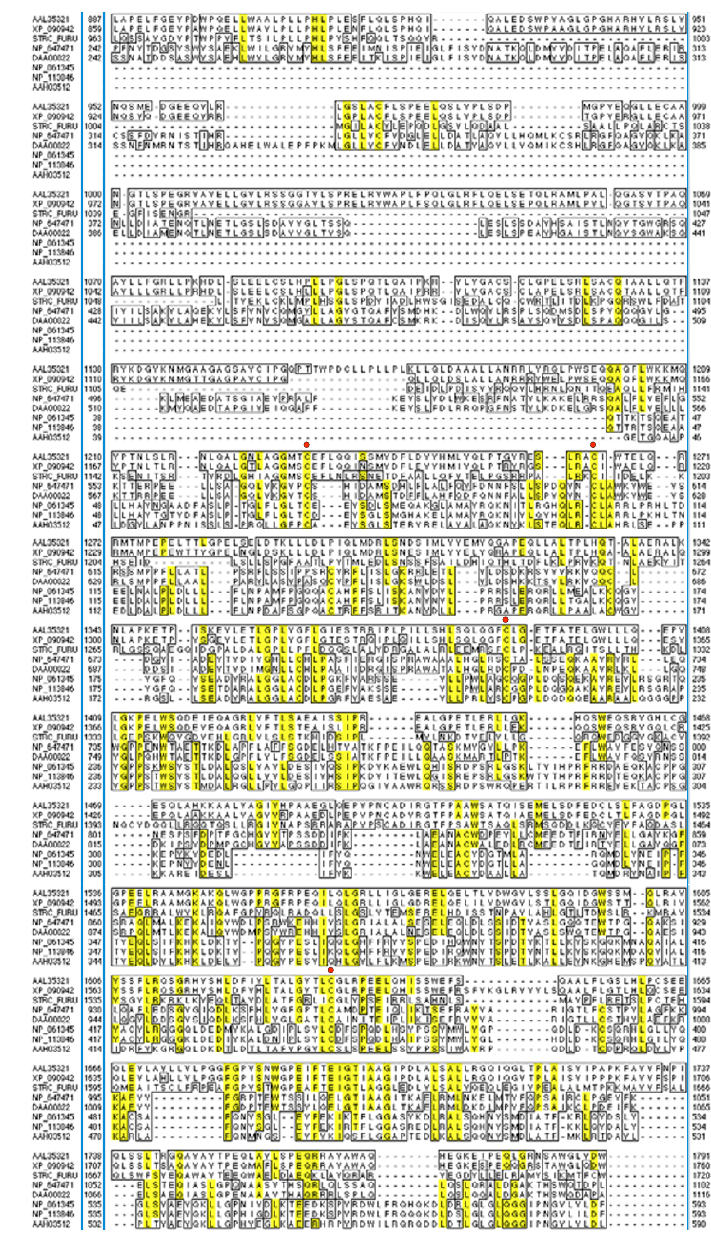
Figure 1 Multiple sequence alignment of stereocilin, otoancorin and mesothelin. Regions of homology are boxed, residues identical in more than 60% of the sequences are shaded in yellow and 4 cysteine residues conserved in all sequences are indicated by red dots. AAL35321, mouse stereocilin (1809 aa); XP_090942, human stereocilin (1778 aa); STRC_FURU, Fugu rubripes stereocilin (see below); NP_647471, mouse otoancorin (1137 aa); DAA00022, human otoancorin (1153 aa); NP_061345, mouse mes- othelin (625 aa); NP_113846, rat mesothelin (625 aa); AAH03512, human mesothelin (621 aa). A gene encoding the putative Fugu fish homologue of stereocilin was identified by a BLAST [18] search of Fugu assembly release 2 (17.05.02) [19] with mouse stereocilin, matching sequences within scaffold 1525 (E-value 8.2 e-58 ). GENSCAN [20] analysis of the genomic DNA was com- bined to local sequence alignments to known stereocilin sequences to yield a putative Fugu stereocilin homologue of 1994 amino acids, including an N-terminal signal peptide sequence and a predicted C-terminal GPI-anchor attachment site. STRC mutations resulting in truncation of stereocilin at amino acid positions preceding the start of the alignment with mesothelin were identified in human families affected by non-syndromal sensorineural deafness linked to locus DFNB16